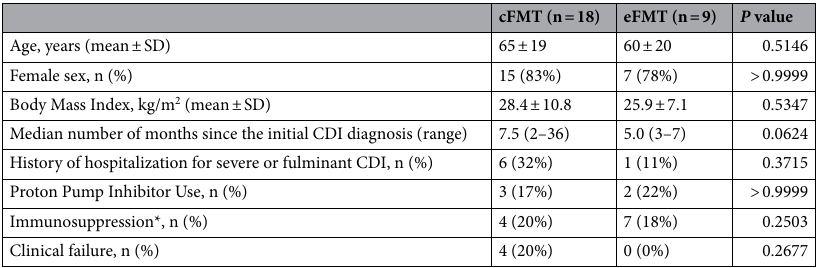
Table 1. Clinical characteristics of patients treated. *Immunosuppression is secondary to medications, including prednisone ≥ 20 mg/day, biologics, and/or immunomodulators such as methotrexate or azathioprine. None of the patients in this cohort had inflammatory bowel